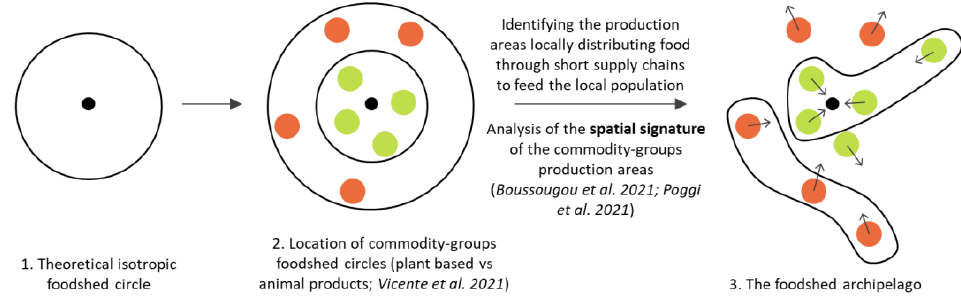
Figure 4. Three-step methodological approach used to shift the focus of a foodshed analysis from an assessment of its size (isotropic circle) to its assessment as a complex of complementary pieces (foodshed